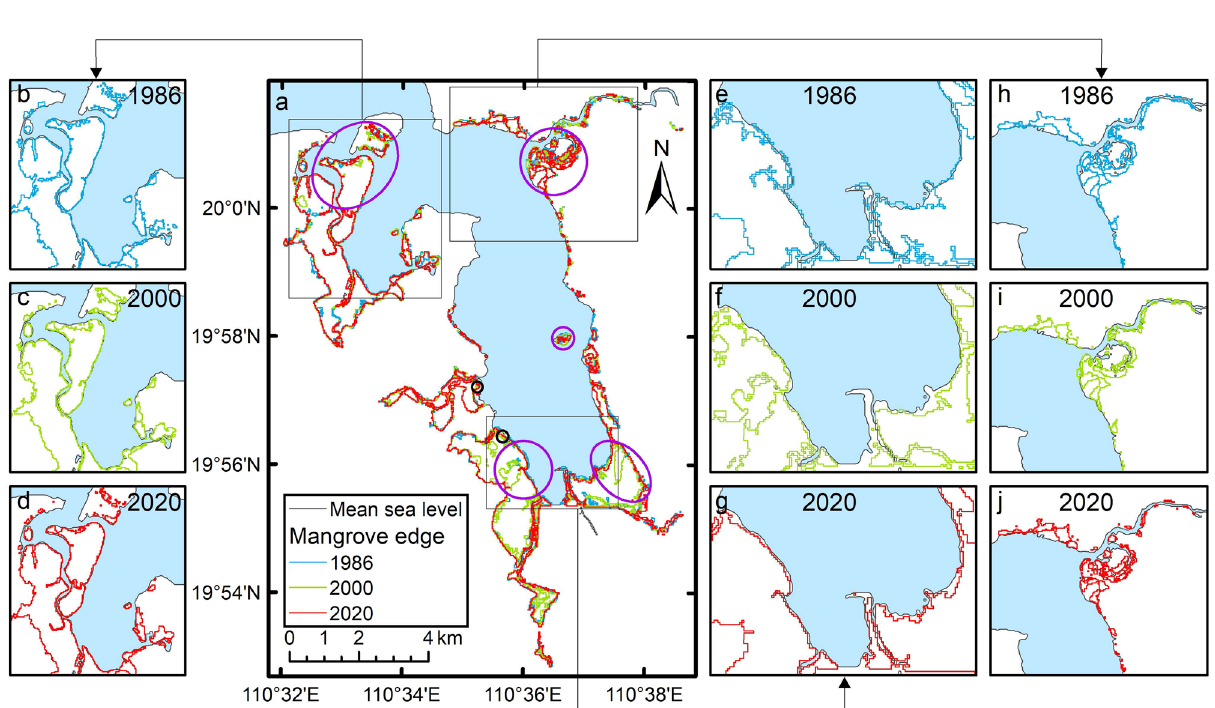
Figure 3. The dynamic changes in low mangrove edges in Dongzhaigang from 1986 to 2020. Maps generated in ArcMap v10.0 (https:// www. esri. com/ en- us/